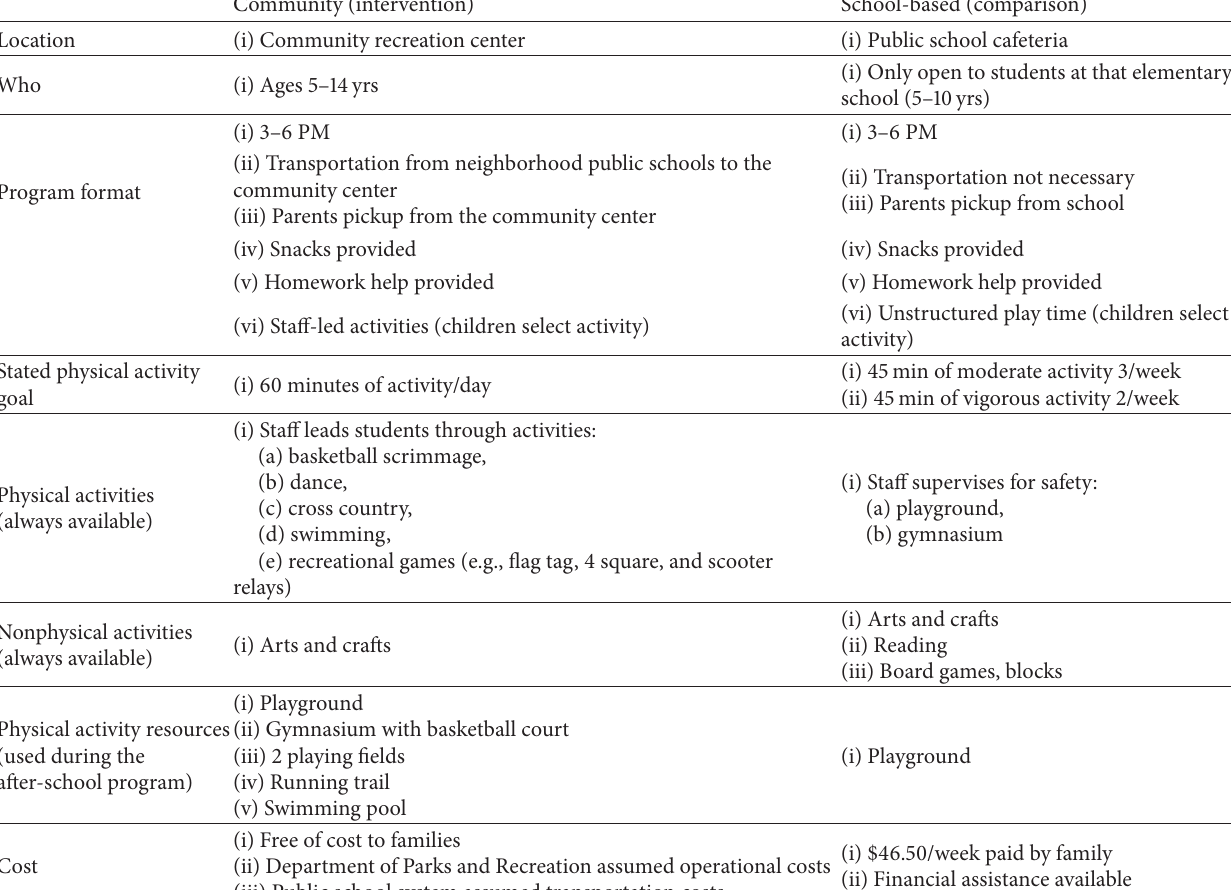
Table 1: Comparison of after-school